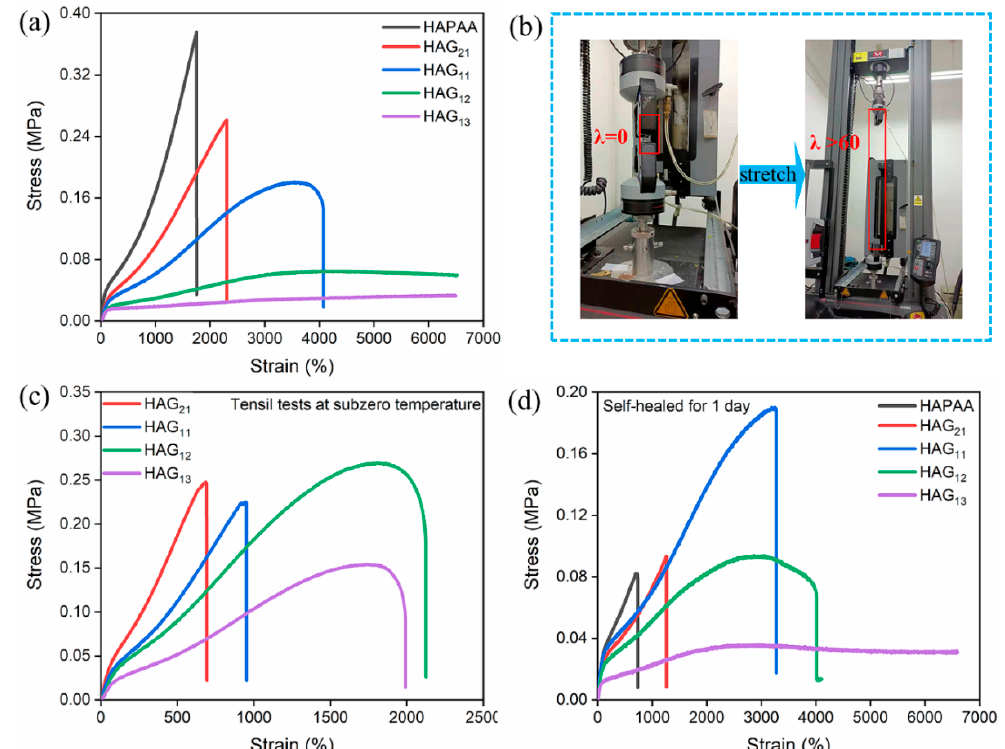
Figure 4. ( a ) Stress–strain curves of HAPAA and HAG x hydrogels. ( b ) The HAG 12 hydrogel can be stretched to more than 6000%. ( c ) The stress–strain curves of HAPAA and HAG x hydrogels after 24 h storage at − 20 °C. The tests were done immediately after the hydrogels were taken out. ( d ) The stress–strain curves of the healed HAPAA and HAG x hydrogels after 24 h at room temperature.